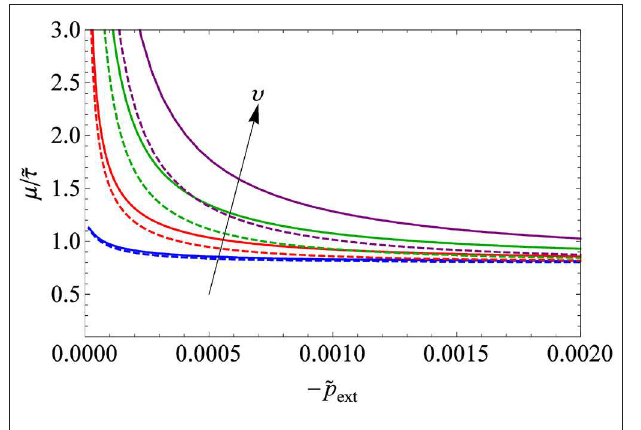
A / A 0 τ FIGURE 8 | Friction coefficient µ/ as a function of the external p ext ) ( − = p ext for h rms 2.5 and dimensionless electrical voltage pressure 1, h ′ rms = − = e e υ [0.01,0.02,0.03,0.04]. = e